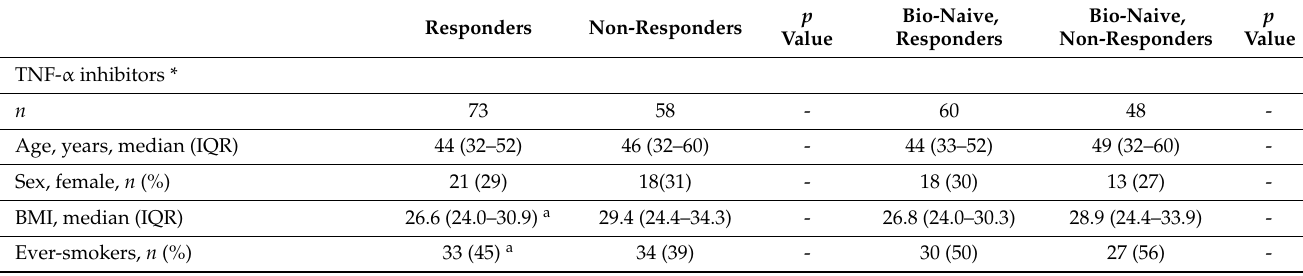
Table 1. Baseline characteristics and levels of blood cell biomarkers of